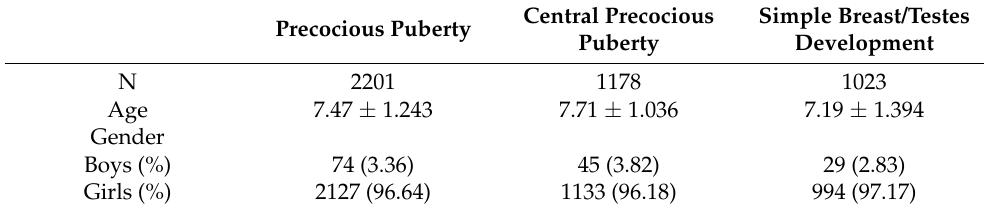
Table 1. Characteristics of 2201 children living in Nanjing with precocious